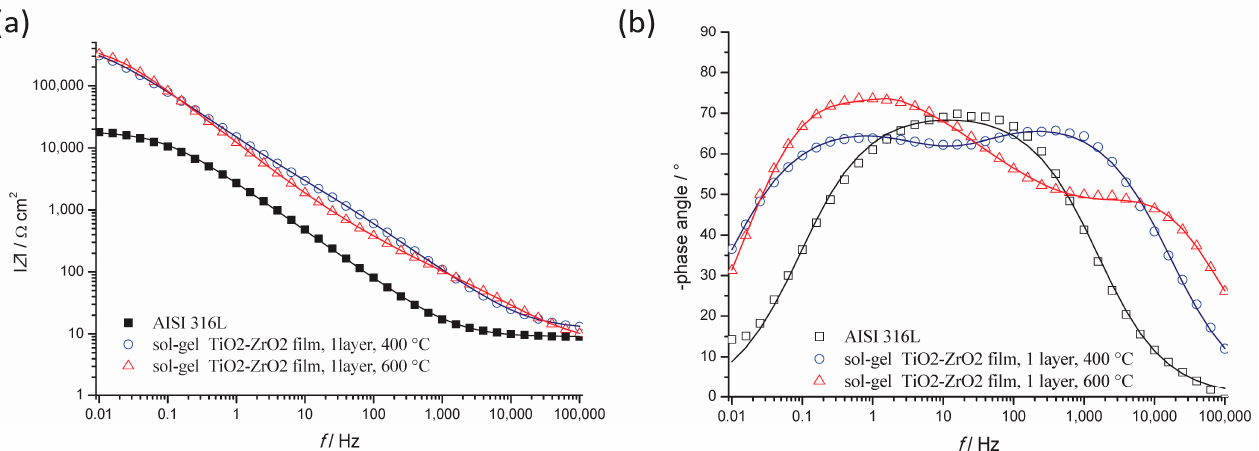
Figure 5. Bode plot: ( a ) impedance modulus; ( b ) phase angle for uncoated AISI 316L stainless steel and coated with TiO 2 –ZrO 2 films annealed at different temperatures. Markers represent experimental data and lines represent fitted data.